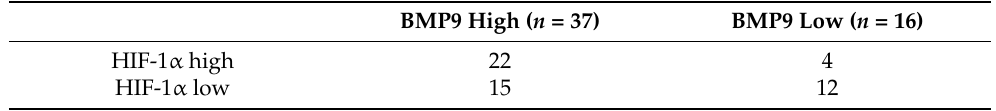
Table 1. BMP9 and HIF-1 α expression in HCC patient samples. BMP9 High ( n = 37) BMP9 Low ( n = 16) HIF-1 α high